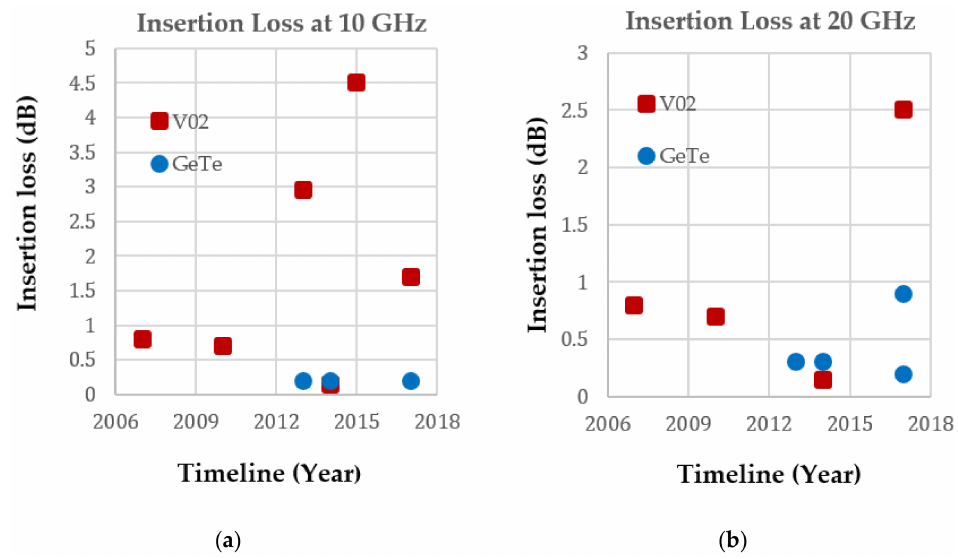
Figure 13. Progress in insertion loss associated with GeTe and VO 2 based switches over the years. ( a ) Insertion loss at 10 GHz; ( b ) Insertion loss at 20